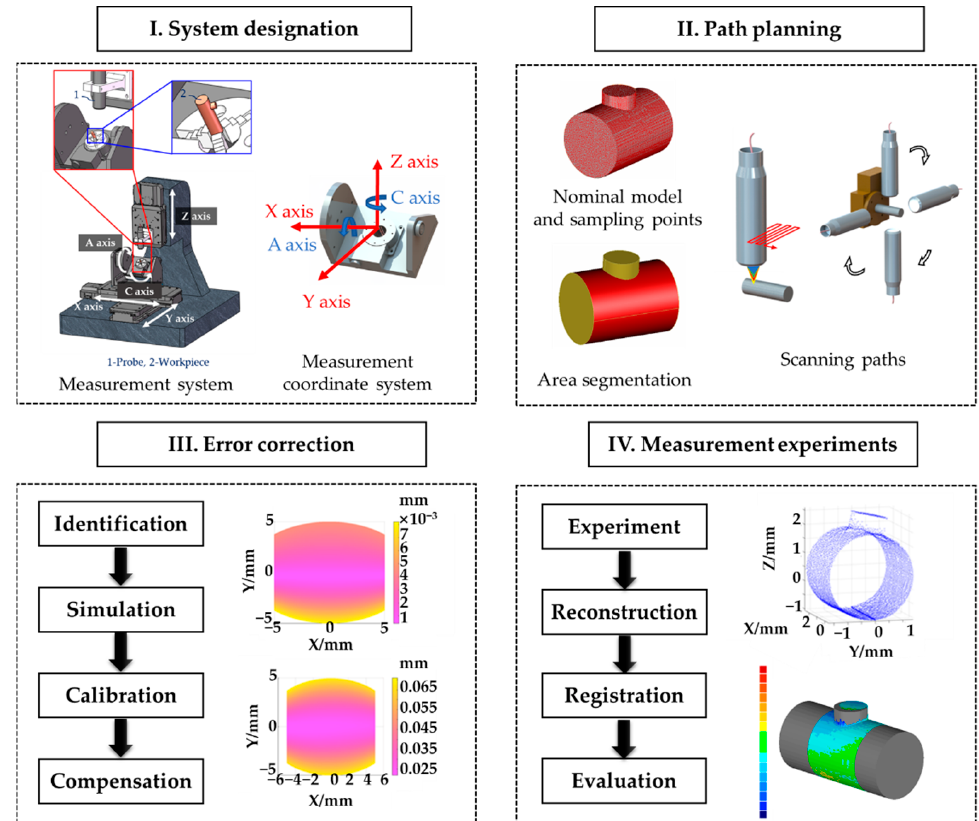
Figure 1. A schematic diagram for overall 3D profile measurements of tiny parts.